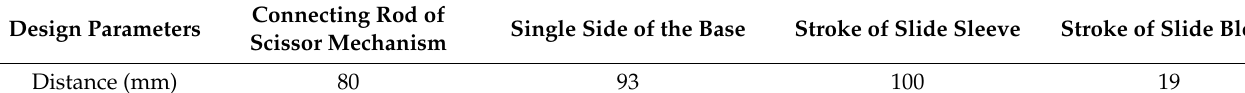
Table 2. Design parameters of scissor mechanism unit.